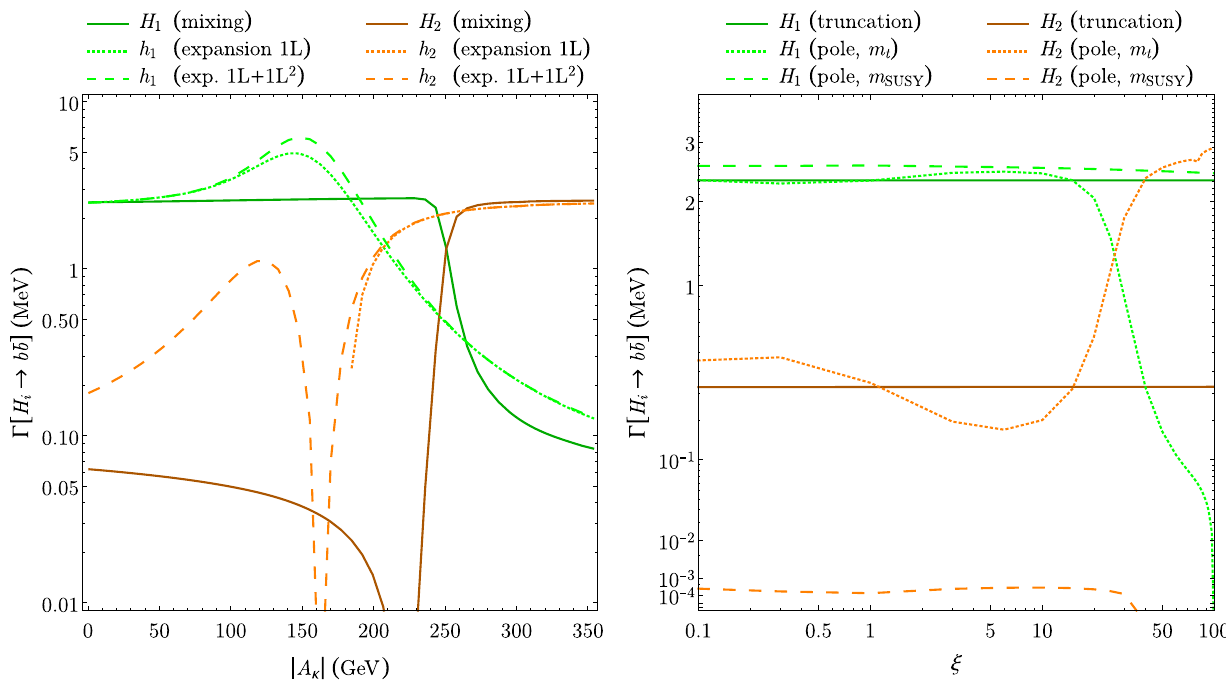
Fig. 12 The decay widths for the b ¯ b channel in the scenario of Fig.11 are displayed. Left: The predictions of Eq.(13) for the decays of the singlet–doublet admixtures H 1 , 2 (solid brown and dark-green) are com- pared to the perturbative expansion at 1L (without resumming the mix- ing, dotted green and orange) and the same perturbative expansion including a 1L 2 term (dashed green and orange). Right: The gauge-